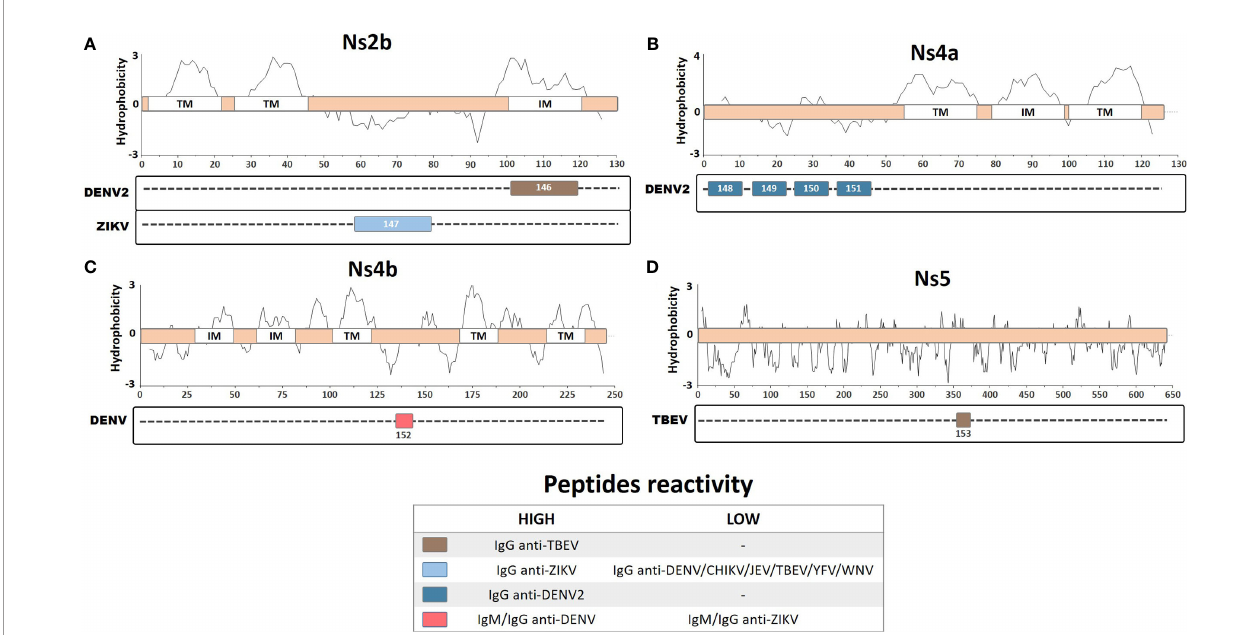
FIGURE 5 | Linear representation of (A) Ns2b protein with topology based on the ZIKV entry query uniprot Q32ZE1, (B) Ns4a protein with topology based on the DENV2 entry query uniprot Q9WDA6, (C) Ns4b protein with topology based on the DENV4 query uniprot Q2YHF0, and (D) Ns5 protein. Linear peptides are labeled by numbers and the antibody reactivity indicated by colors. The hydrophobicity prediction pro fi le was determined using the amino acid sequence of the ZIKV (Genbank YP_002790881), DENV2 (Genbank ACA48840), DENV4 (Genbank CH99664), and TBEV (Genbank ADQ00969.1), with the Kyte & Doolittle hydropathy score scale (J. Mol. Biol. 157:105-132(1982). TM, Transmembrane region; IM, Intramembrane